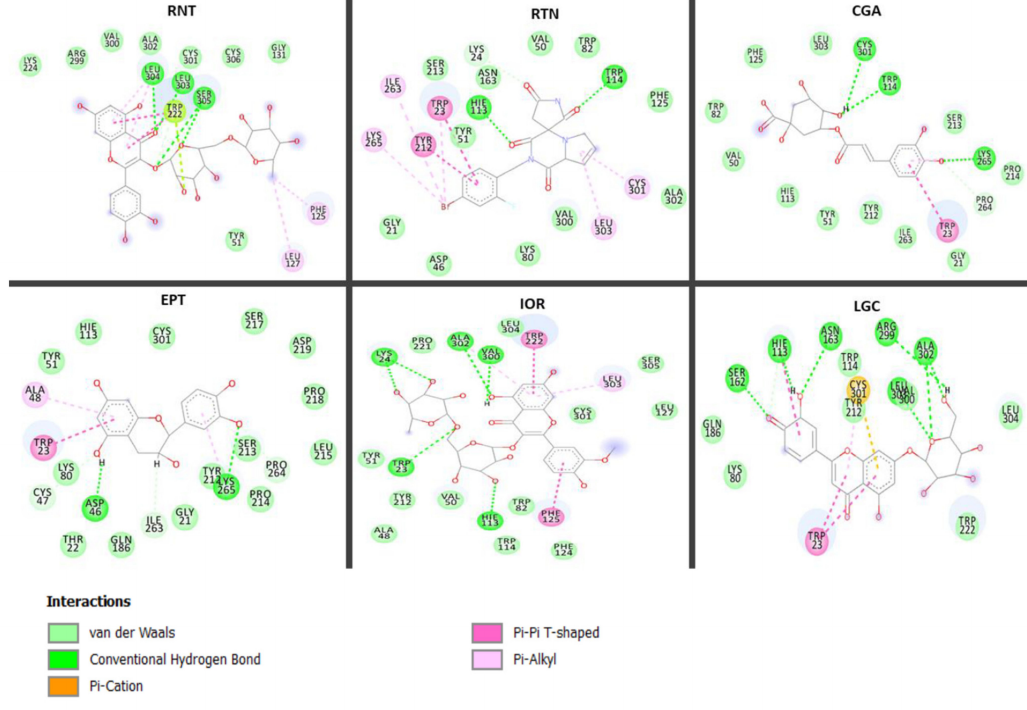
Figure 7. Interaction types and plots between phenolic compounds, standard drug and aldose reductase. RNT: Ranirestat; RTN: Rutin; IOR: Isohamnetin-3- O -rutinoside; LGC: Luteolin7- O -beta- D -glucoside; CGA: Chlorogenic acid; EPT: